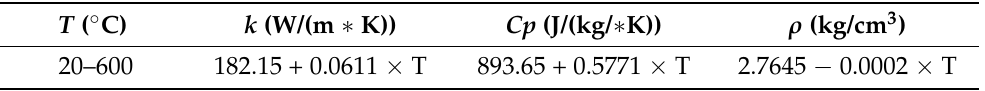
Table 2. Thermal conductivity ( k ), specific heat ( Cp ) and density ( ρ ) functions.